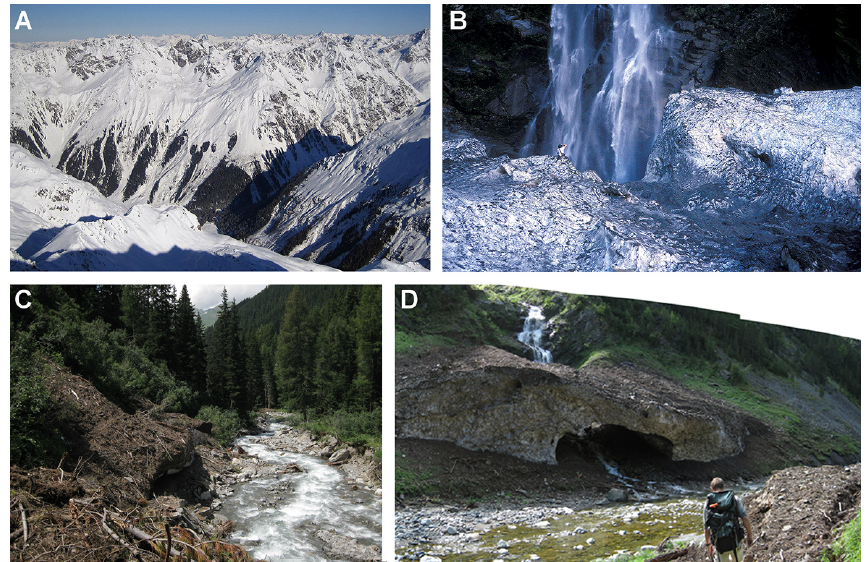
Fig. 1. Relevance of snow cover and avalanche erosion in mountainous terrain: (A) large avalanche chutes in the eastern Swiss Alps. (B) Sediment-rich avalanche debris below steep bedrock sluice, Matukituki Valley, Southern Alps, New Zealand; note person for scale. (C) Eroded snow-avalanche bridge with thick cover of organic debris, Flüelabach, eastern Swiss Alps (this study). (D) Remnants of snow- avalanche bridge, Zügenschlucht, eastern Swiss Alps (this